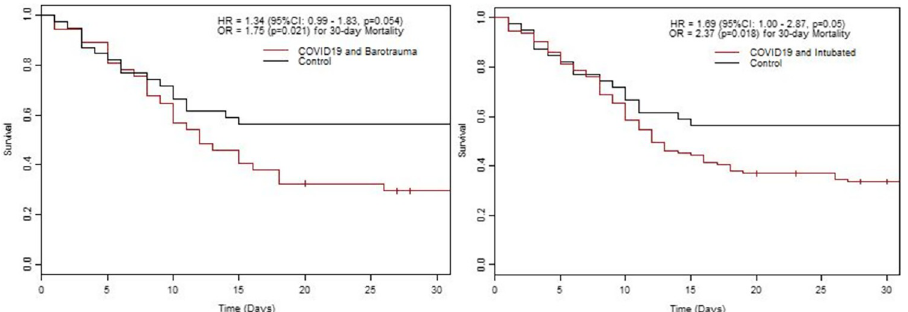
Fig 2. a: In the comparison to controls, patients with COVID and barotrauma had worse 30-day mortality (OR = 1.75, p = 0.021) and overall survival (HR = 1.34, p = 0.054). b: In the comparison to controls, patients with COVID and Intubated had worse 30-day mortality (OR = 2.37, p = 0.018) and overall survival (HR = 1.69, p = 0.05). (8.8 ± 3.3 vs. 6.6 ± 3.0, p < 0.01), lower mean initial P/F ratio (100.1 ± 59.0 vs. 123.7 ± 92.1,